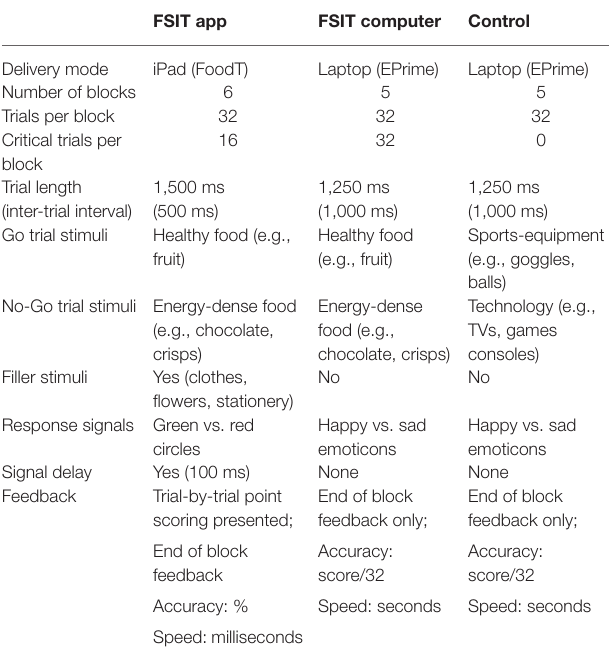
TABLE 2 | Differences between the food-specific inhibition training (FSIT)- computer and FSIT-app tasks. FSIT